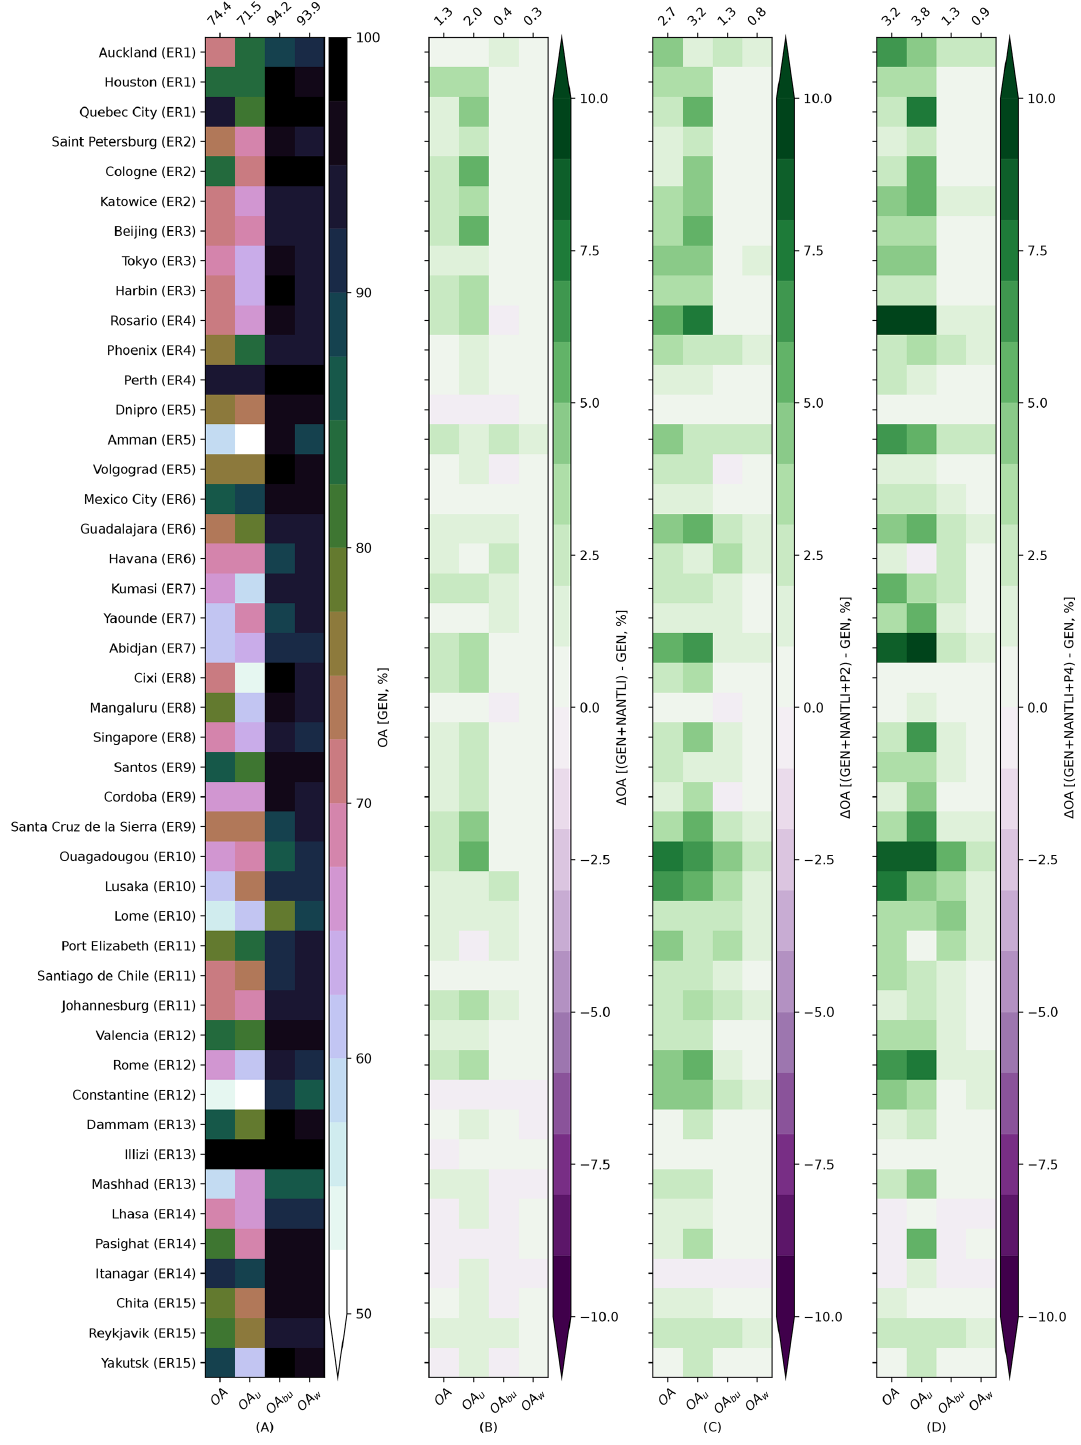
Figure B1. Overall accuracies for the various input feature experiments: absolute overall accuracies for all cities for GEN (a) and differences in overall accuracies for experiments GEN+NANTLI (b) , GEN+NANTLI+P2 (c) , and GEN+NANTLI+P4 (d) compared to GEN. Numbers on the top x axis indicate the average overall accuracy (change) across all cities. ER refers to urban ecoregion.